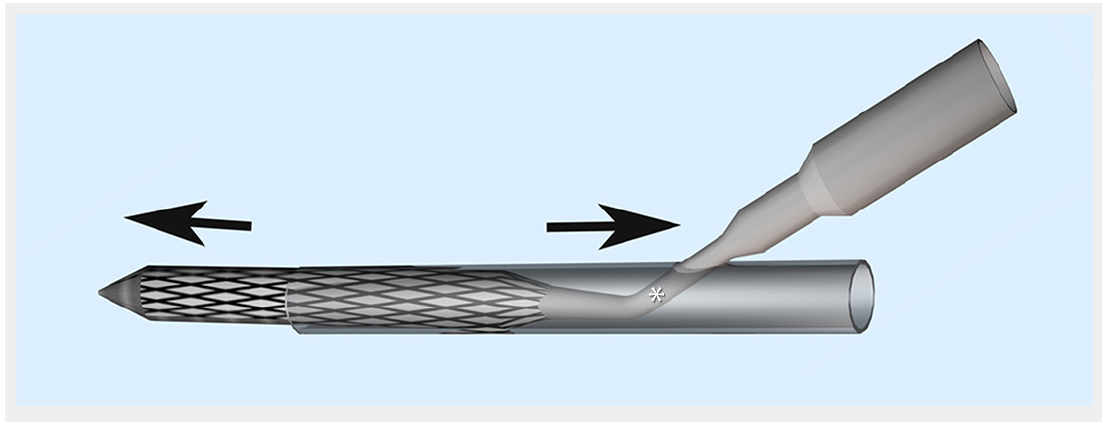
Schematic view of the concept for a new virtually wall-less cannula designed for bidirectional flow. The performance gain achieved with the virtually wall-less cannula design can be attributed to a short, narrower (*), somewhat less performant cannula segment at the point of insertion (centre), which allows not only for antegrade flow (left), but also for some back flow in parallel towards the limb